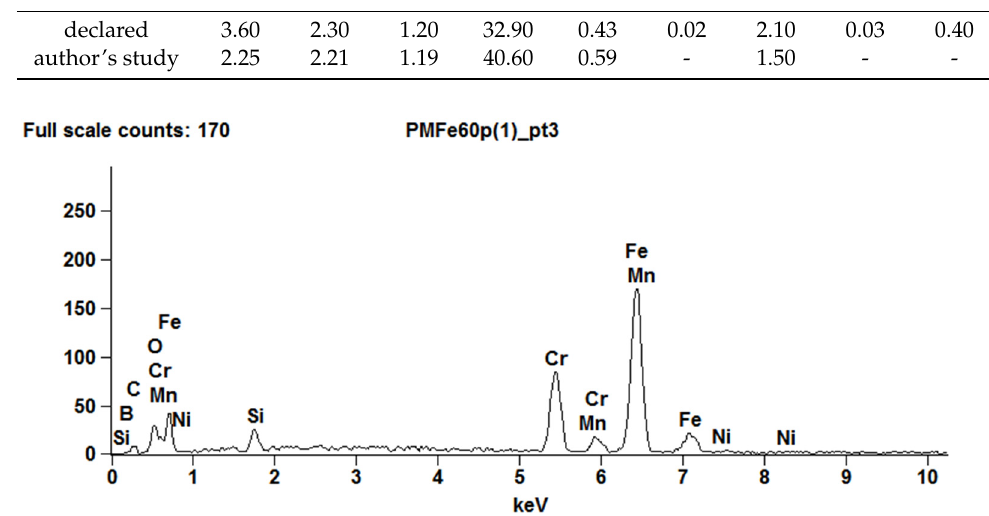
Figure 7. X-ray energy spectrum of PMFe60P padding weld. Figure 7. X ‐ ray energy spectrum of PMFe60P padding weld.